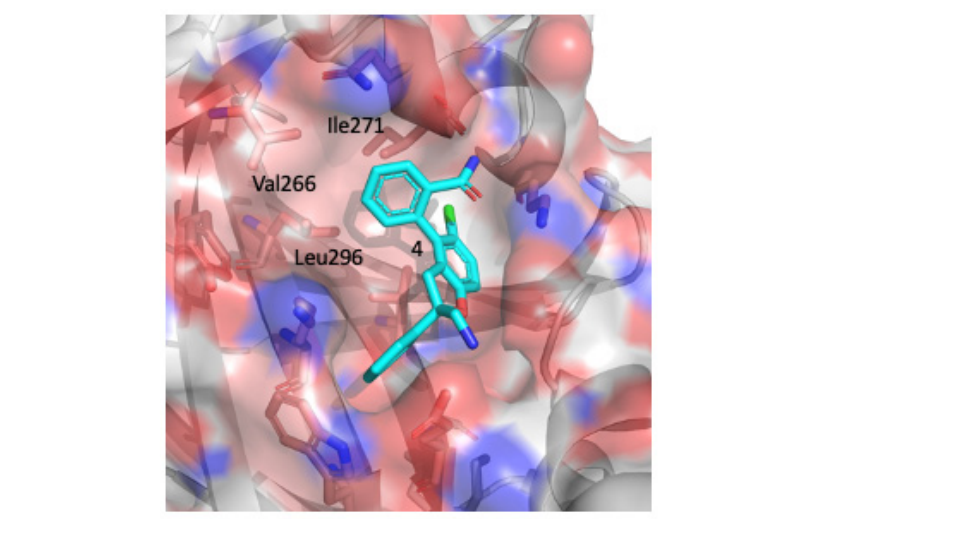
Figure 4. Binding mode of Novartis compound 4 in complex structure (PDB: 8A0U). The core structure is a dihydrobenzofurane ring with a phenyl substituent at position 4. The hydrophobic residues Ile 271, V266, and Lue296, shown in salmon colored sticks, interact with the phenyl substituent.